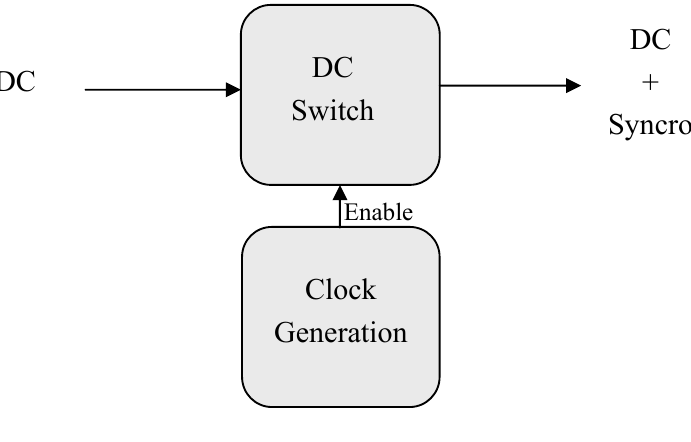
Figure 2 . General clock